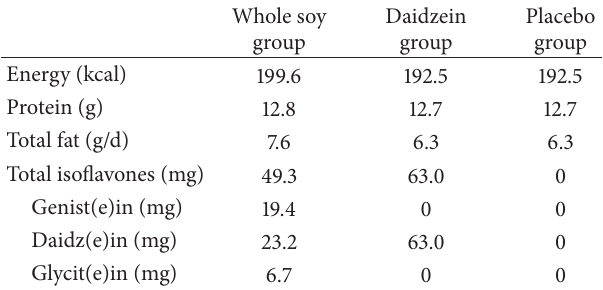
Table 1: Nutrient profiles of the 3 study supplements (daily